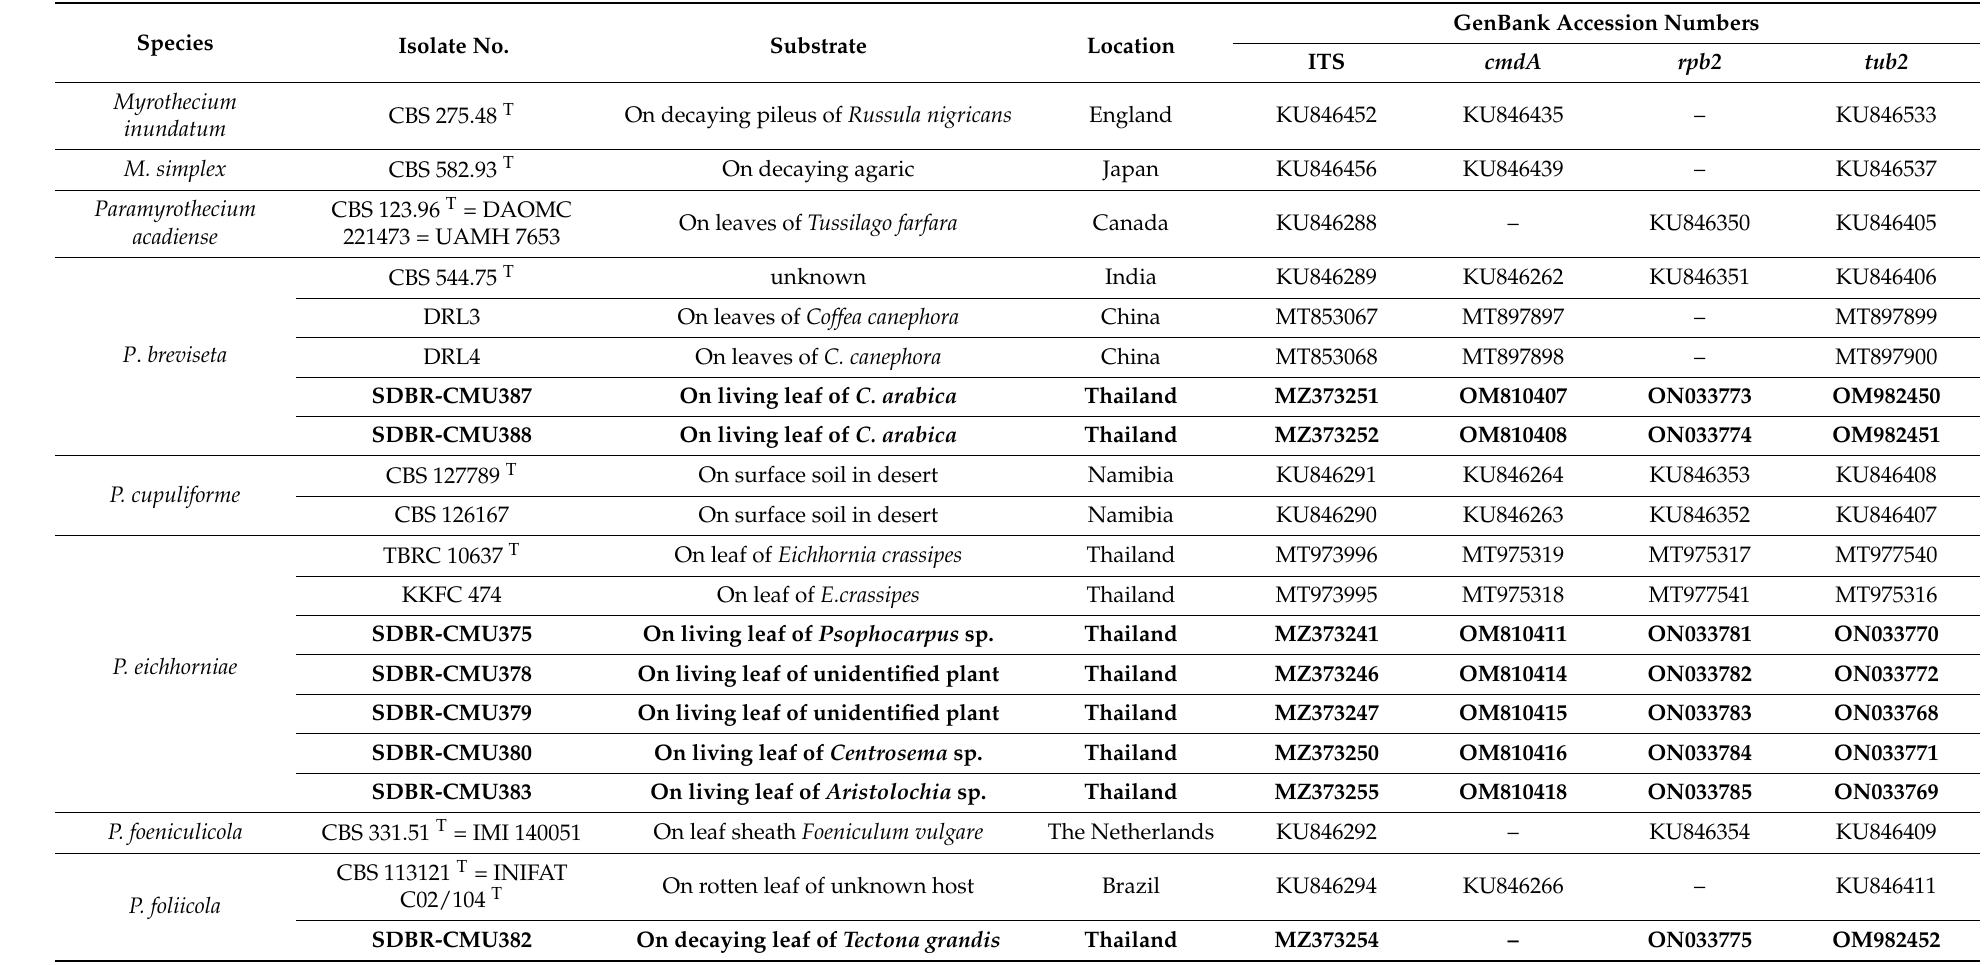
Table 4. Taxa used in the phylogenetic analyses and their corresponding GenBank numbers.